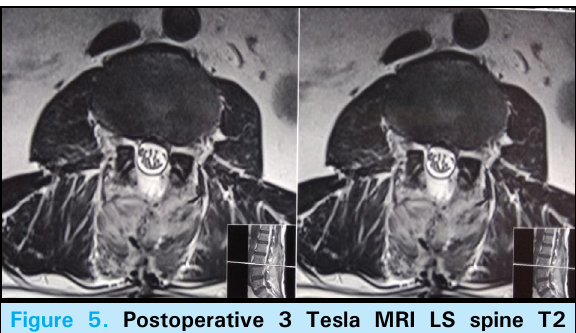
Figure 2. Preoperative 3 Tesla MRI LS spine T2 weighted axial section at the L